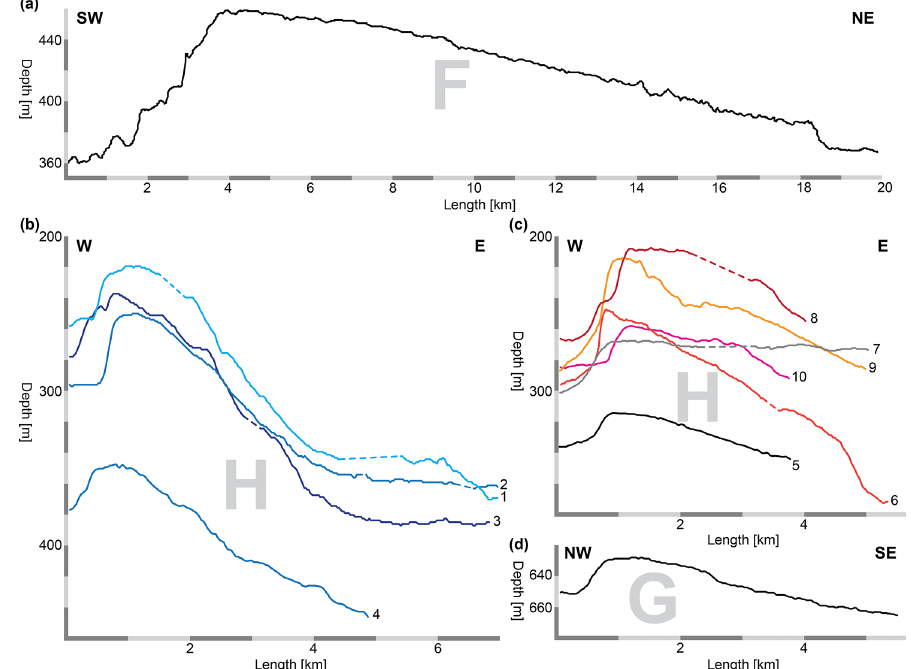
Figure 5. Bathymetric profiles across (a) the lateral moraine of morphological Class F, (b) Class H crescent-shaped ramps 1–4, (c) Class H ramps 5–10, and (d) the GZW of Class G in inner Stancomb-Wills Trough. For the locations of profiles in (a) , (b) , (c) , and (d) , see Figs. 1, 3, 4, and 6,